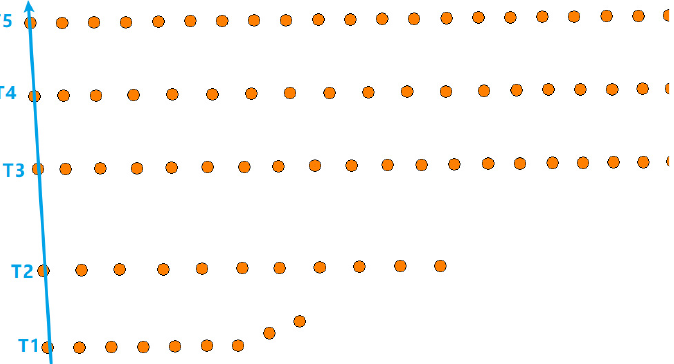
Figure 10. Wind direction is 358-degree. The wake loss of turbines in this column is calculated at different value of the wake decay constant. Figure 9 shows that wake loss in the main wind sector is not the lowest. The 225-degree sector has the greatest wake loss, followed by the sector adjacent to the NE secondary main wind direction. The wake flow in the 315-degree sector is kept to a minimum with observation(obs.) wake is 10.81%, whereas the wake loss in the 135-degree sector in the main wind direction is relatively high with observation wake is 13.62%, indi- cating that the wind farm’s layout scheme needs to be optimized.